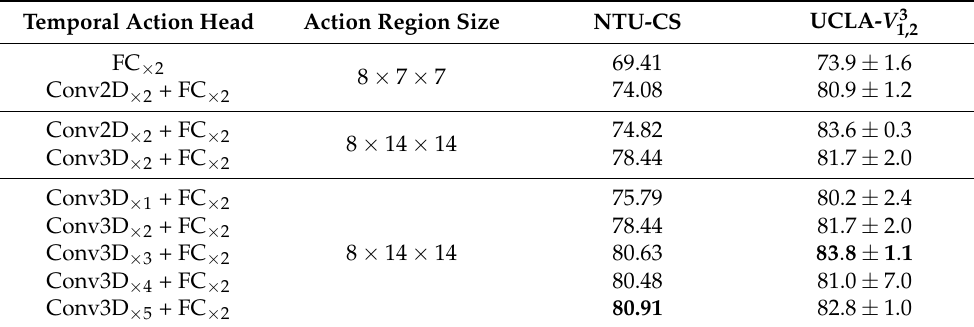
Table 4. Experimental results according to layer type and depth. The input channel dimension of the action region features is 256, and the output channel dimensions of the FC and Conv2D layers are 1024 and 256, respectively.